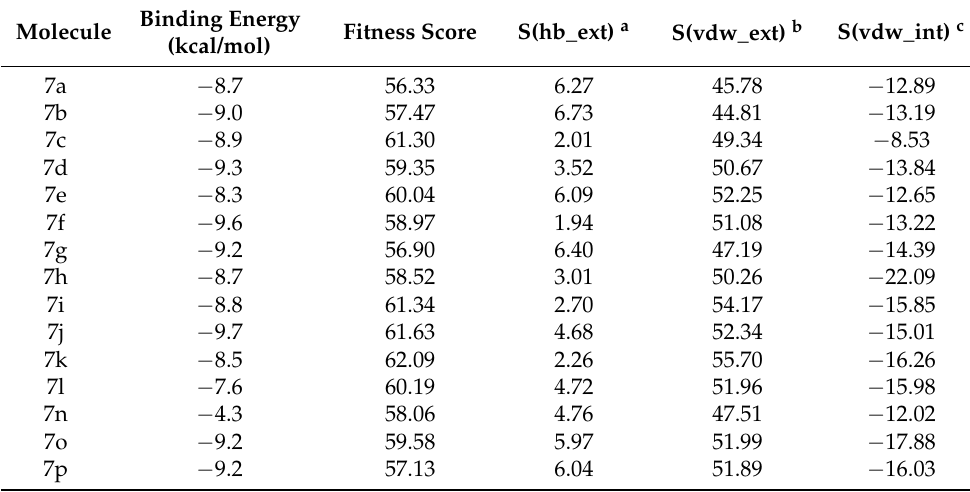
Table 2. Molecular docking results of selected dataset against S. epidermidis TcaR.